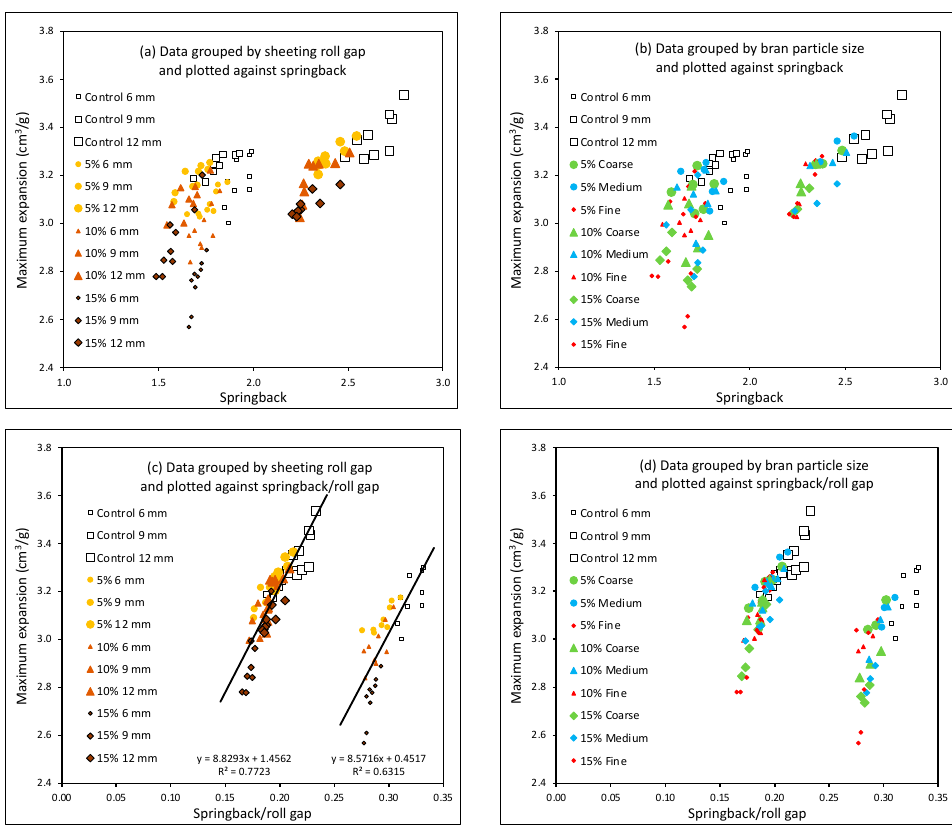
Figure 7. Maximum DDD expansion versus springback ( a , b ) and versus springback/roll gap ( c , d ), for doughs with different levels and particle sizes of bran, and sheeted at 6, 9 and 12 mm roll gaps. The data are grouped by sheeting roll gap ( a , c ) and by bran particle size ( b , d ).